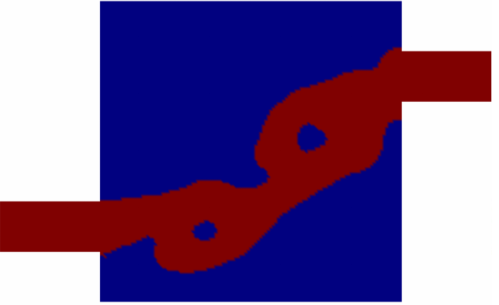
Figure 5. Tesla valve optimized with the full length scale control optimization Formulation